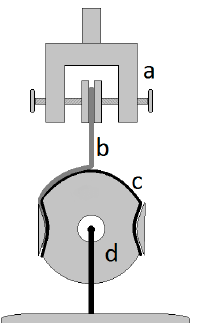
Figure 3. Schematic of the peel test set-up: ( a ) top clamp, ( b ) polymer composite sample, ( c ) polyvinyl chloride (PVC) veneer, ( d ) bottom wheel fixture.